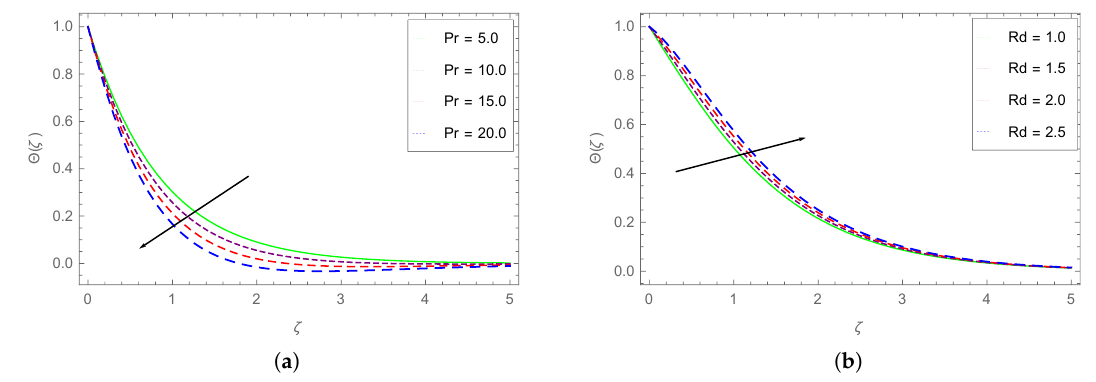
Figure 13. ( a ) Impact of Pr on θ ( ζ ) and ( b ) influence of Rd on θ ( ζ ) .